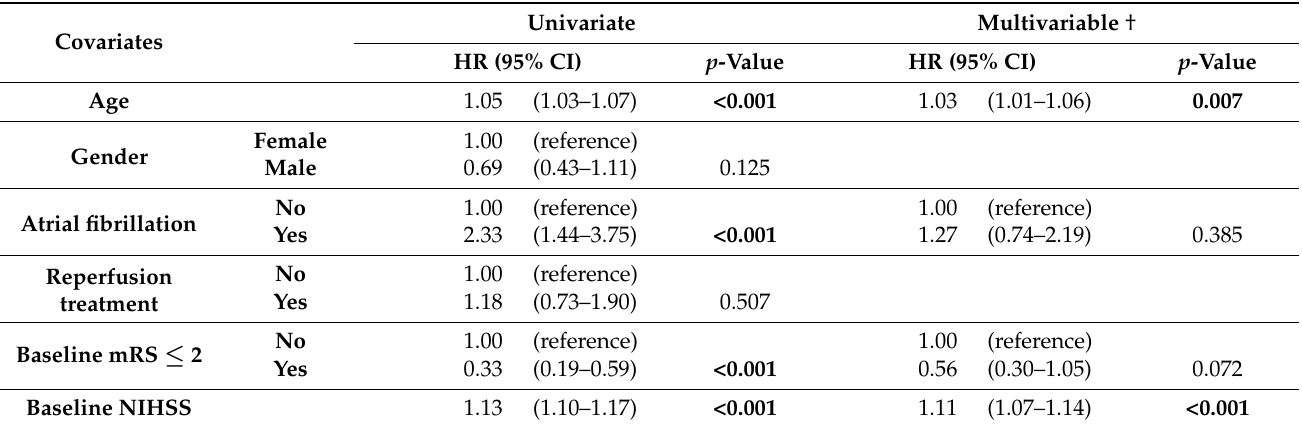
Table 4. Univariate and multivariable Cox regression analysis for overall survival of stroke patients.